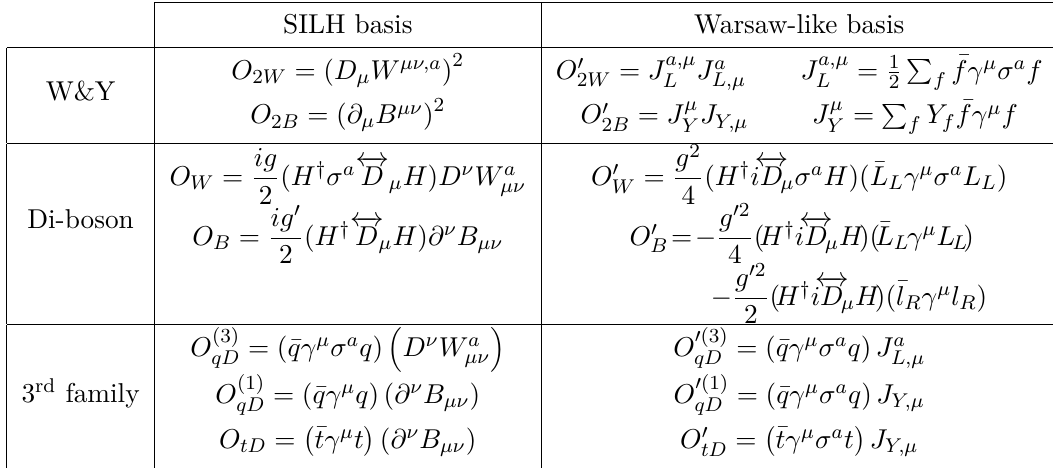
is the hypercharge of f